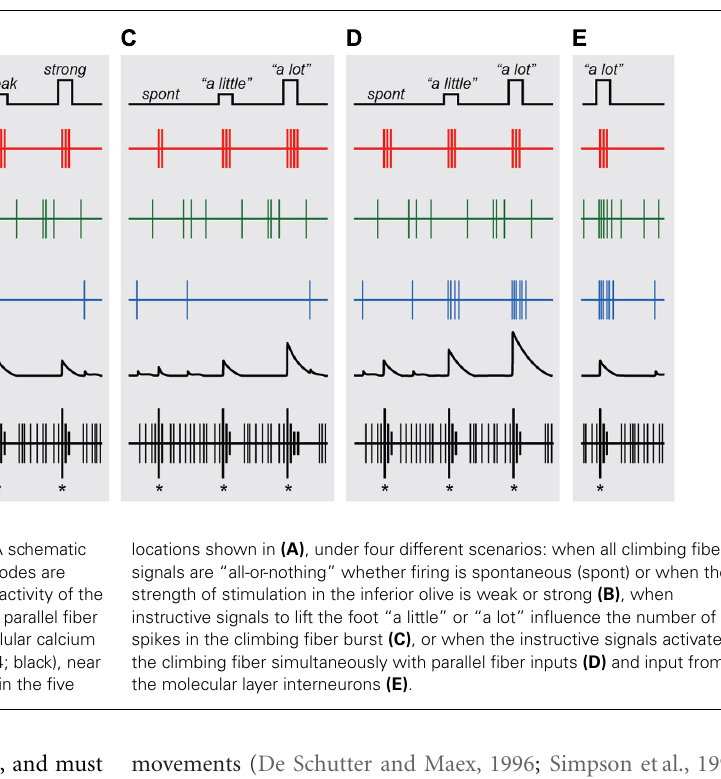
FIGURE 1 | Graded instructive signals in a Purkinje cell. (A) A schematic diagram of a Purkinje cell and its different synaptic inputs. Electrodes are placed in different locations to measure the extracellular spiking activity of the climbing fiber (1; red), a molecular layer interneuron (2; green), a parallel fiber (3; cyan) and the Purkinje cell axon (5; black). In addition, intracellular calcium signals are imaged in one of the Purkinje cell’s distal dendrites (4; black), near electrodes 2 and 3. (B–E) Spikes and calcium signals measured in the five